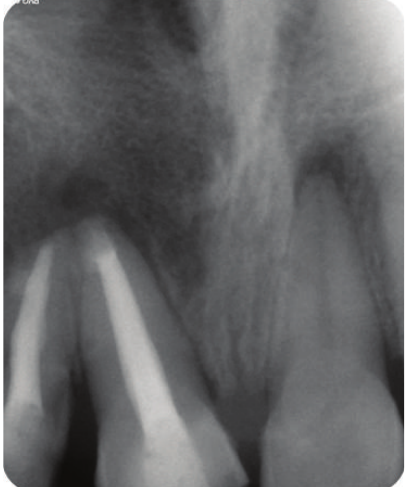
Figure 46: 18-month followup IOPA radiograph.